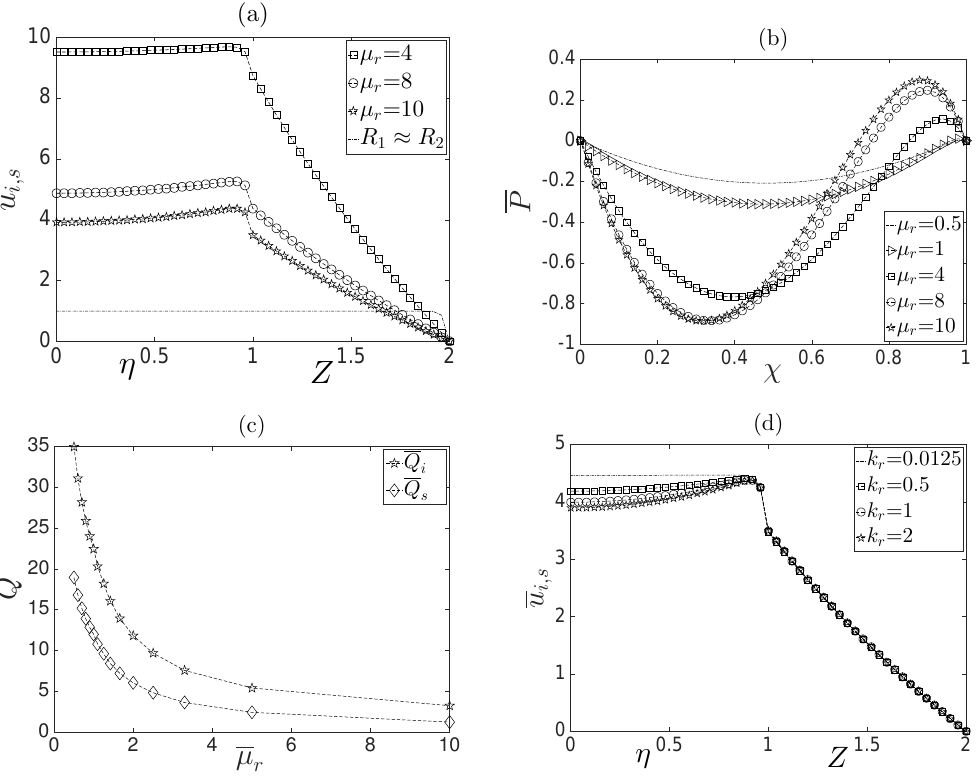
Figure 5. Influence of the viscosity ratio on the dimensionless velocity profiles ( a ) and dimensionless pressure ( b ). Volumetric flow rate as a function of the viscosity ratio ( c ) and the effect of the thermal conductivity ratio between the surrounding and inner fluids on the dimensionless velocity profiles ( d